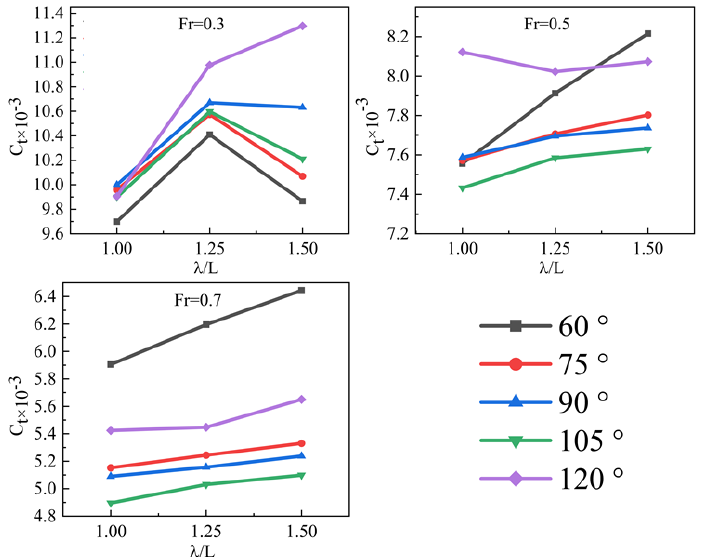
Figure 11. Total resistance coefficient of pentamaran with different front outrigger inclination angles in regular waves. Table 7. Average resistance values in regular